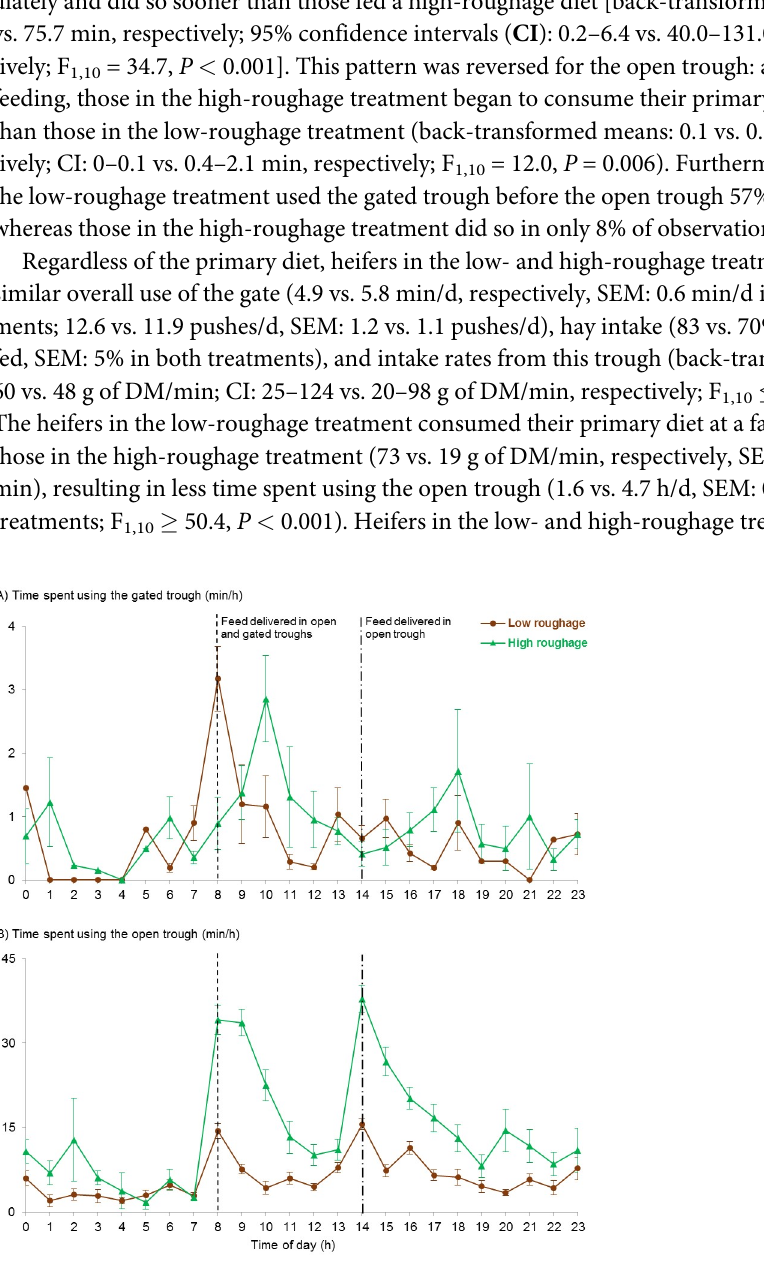
Fig 2. Descriptive data for diurnal patterns of trough use. The mean ± SEM amounts of time heifers spent using the (A) gated or (B) open feed trough are shown by hour of the day. At 0800 h, all heifers were fed Sudan grass hay behind a weighted gate that must be pushed open to gain access. The primary diet treatments were delivered to the open trough at 0800 and 1400 h, and consisted of either a total mixed ration with 12% forage (as fed, low roughage, n = 6) or 100% Sudan grass hay (high roughage, n =